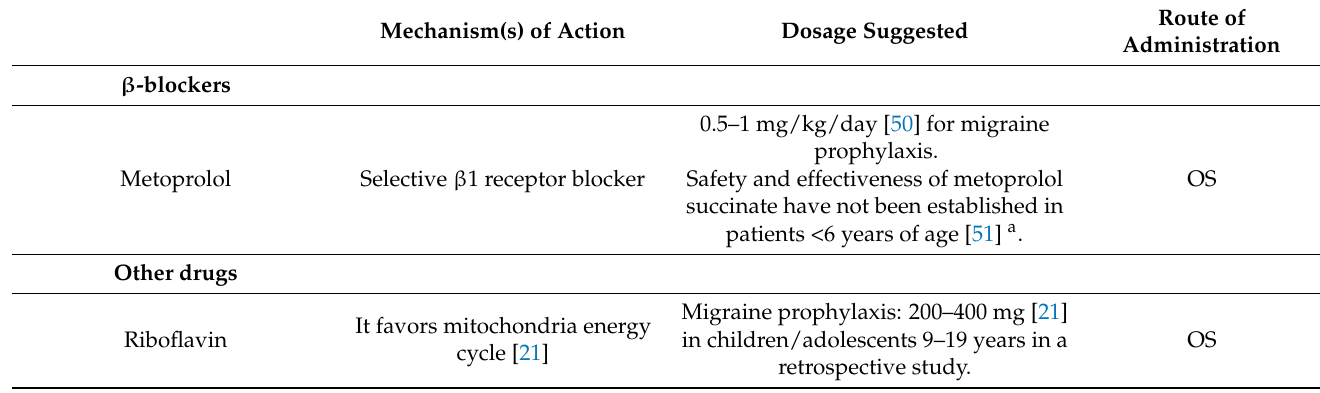
Table 3. Drugs used or evaluated in vestibular migraine and recurrent vertigo of childhood (no